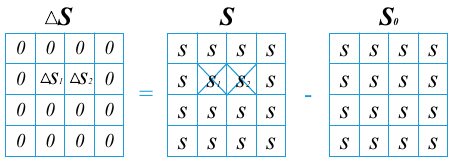
Figure 2. An example for the sparsity of slowness difference.